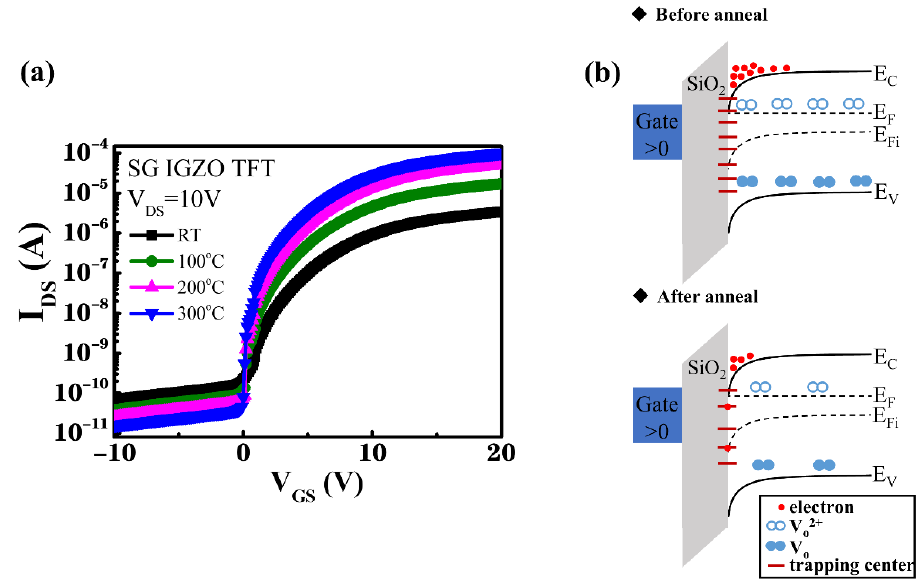
Figure 5. ( a ) I DS –V GS transfer characteristics of SG TFTs with a 33% O 2 plasma–treated IGZO channel layer and annealed at temperatures from RT to 300 °C. ( b ) Energy band diagrams for the SG TFTs before and after the thermal annealing process.